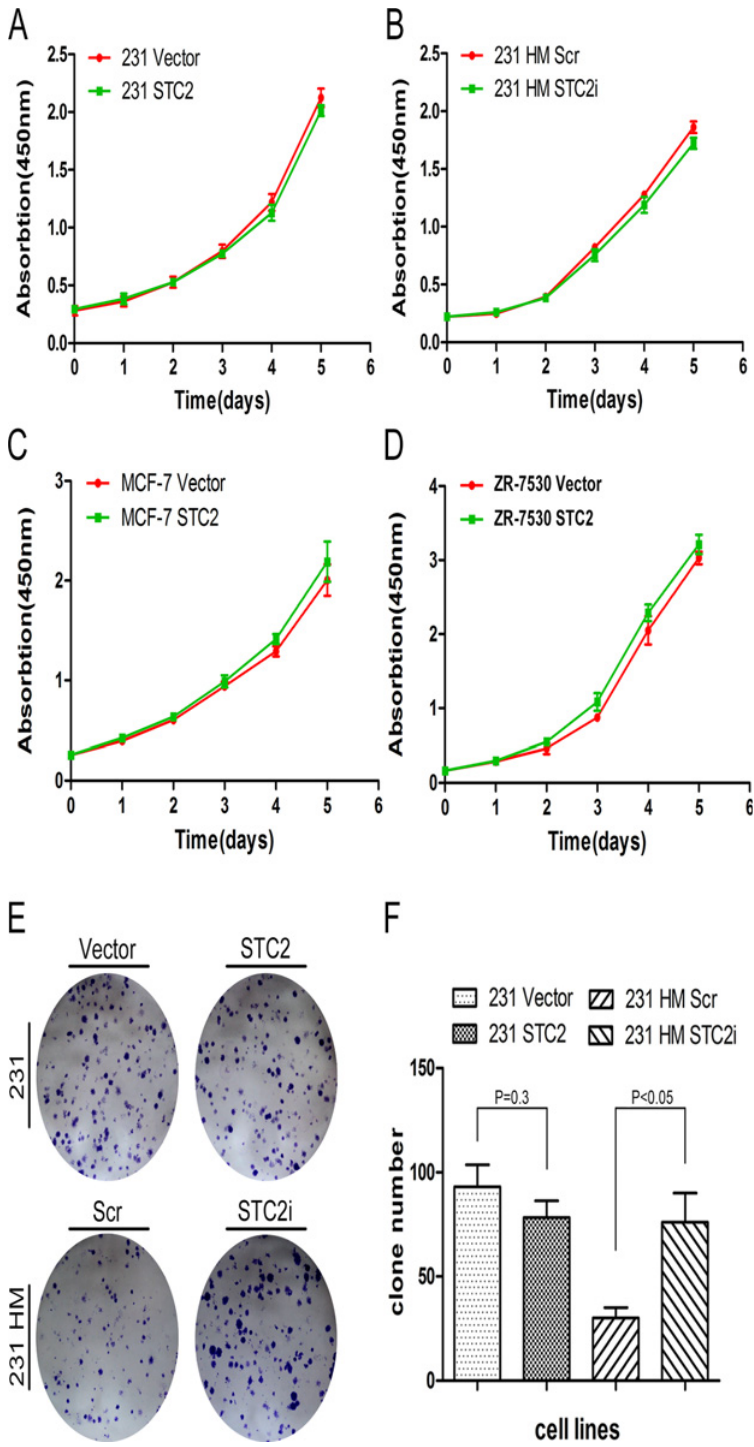
Fig 2. STC2 has little effect on cell proliferation. A-D , Detection of cell proliferation by CCK8 (P < 0.05). Error bars = 95% CIs. E-F , Colony formation assay. E , Representative images of 231 STC2 cells and 231 HM STC2i cells and their corresponding controls, and F , Quantitative analysis of the number of clones (P < 0.05). Error bars = 95% CIs.